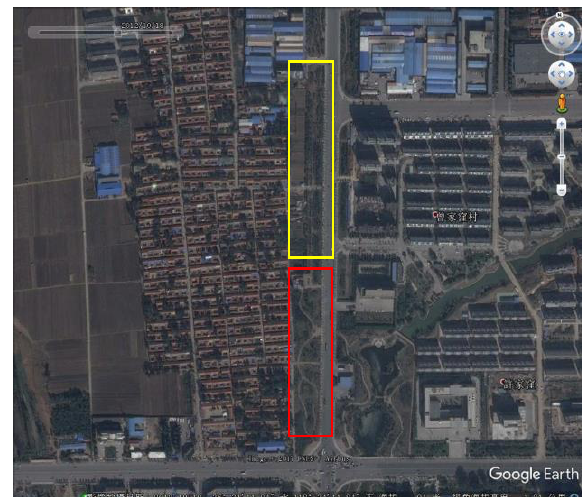
Figure 10. Available Google Earth images 2012 for S2.